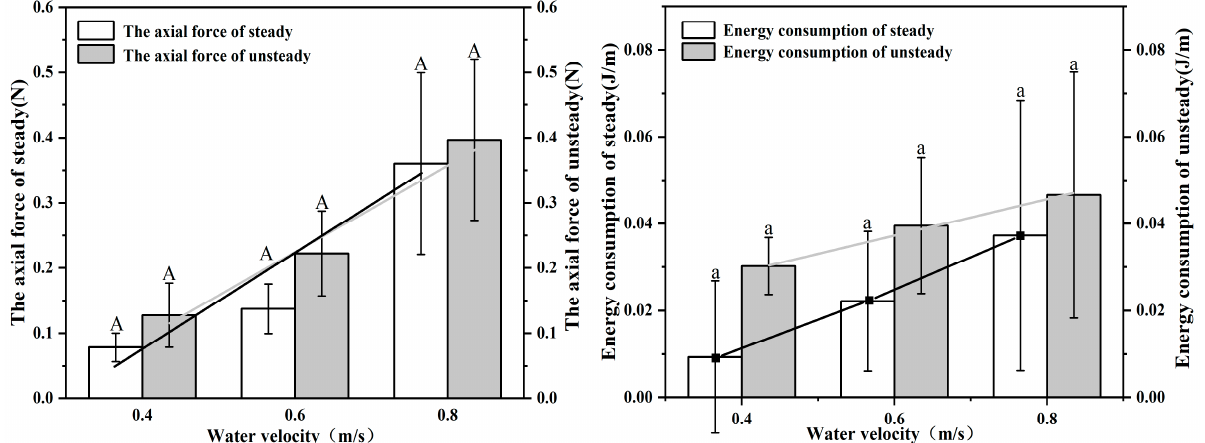
Figure 6. Relationship between energy consumption and water flow velocity in steady/unsteady mode of S. malacanthus. Different upper cases indicate the significant the difference of water velocity in the axial force of steady/unsteady treatments; Different lower cases indicate the significant the difference of water velocity in energy consumption of steady/unsteady treatments.